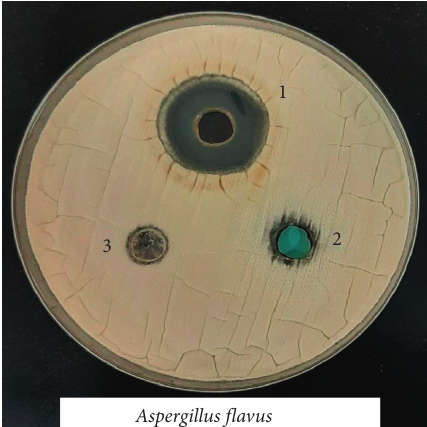
Figure 16: Microbiological screening of Ni(II), Cu(II) and Mn(II) complexes against Aspergillus flavus.